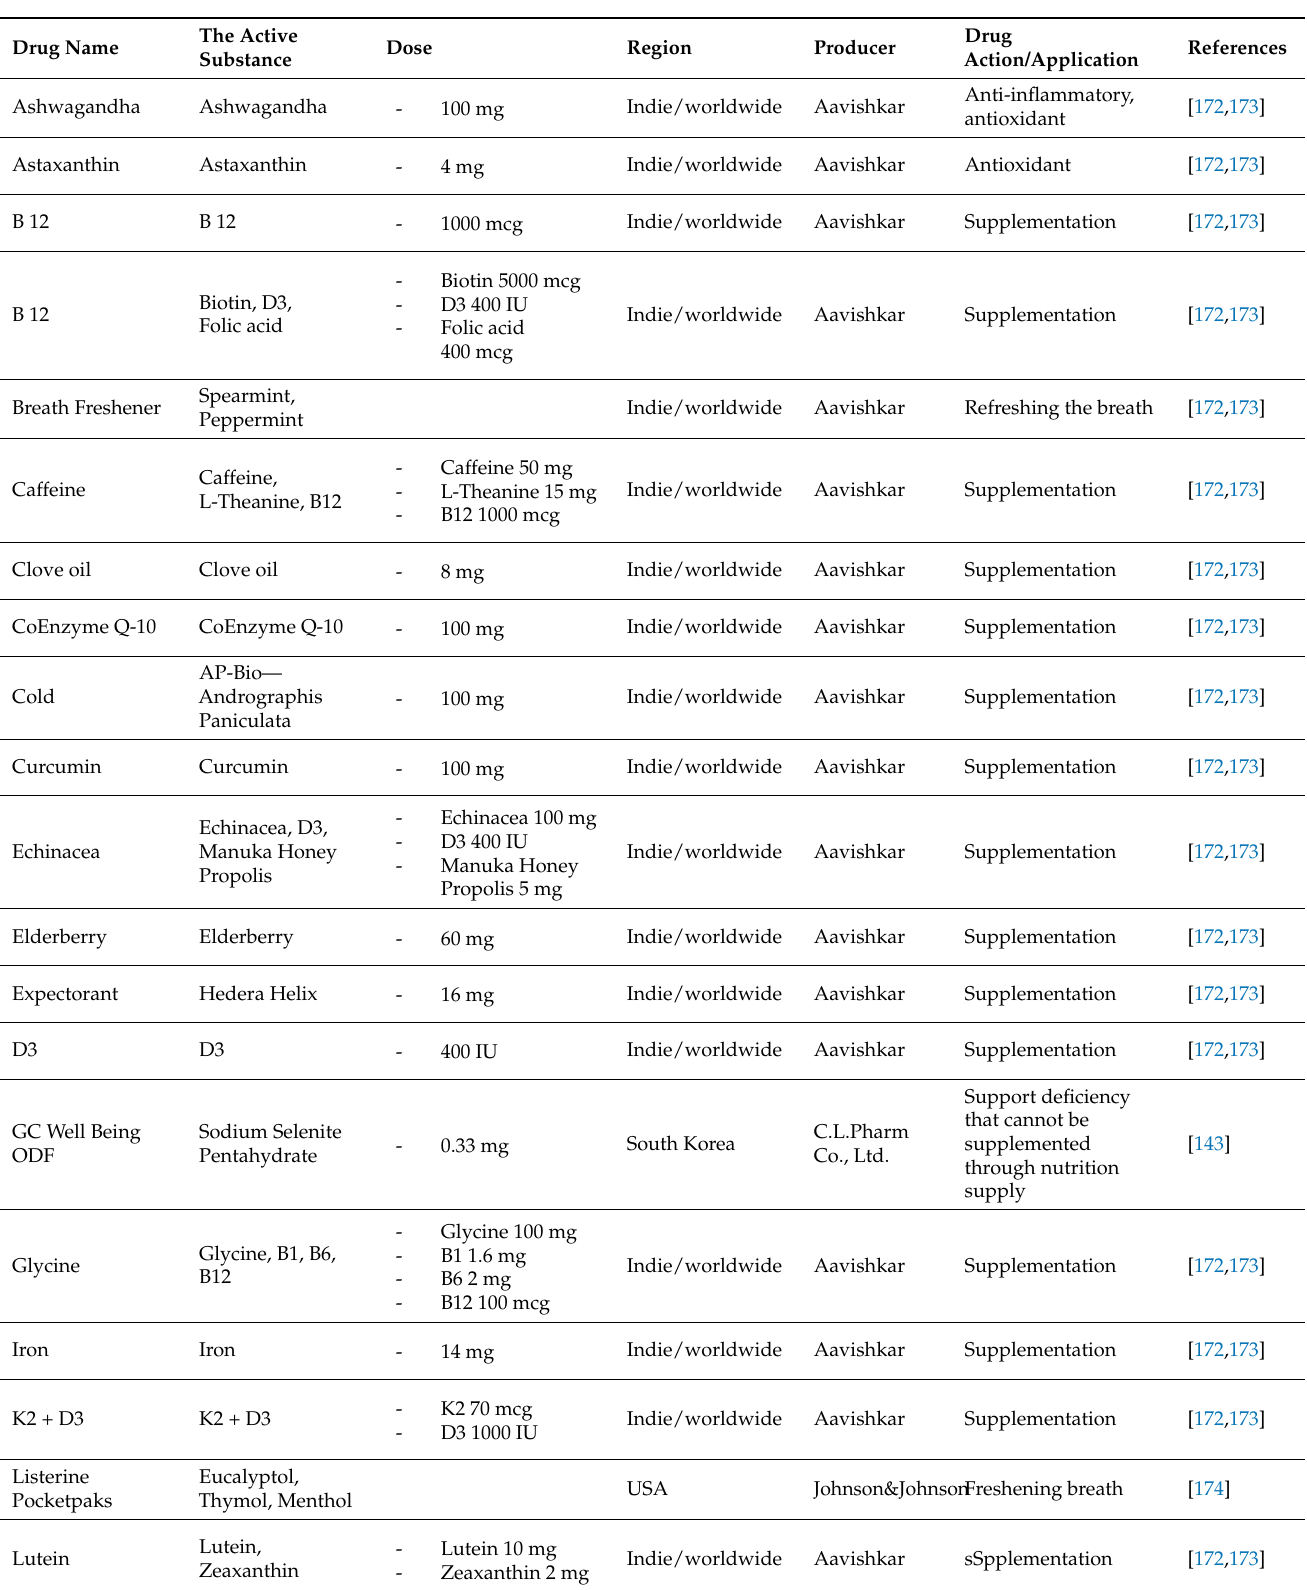
Table 4. Examples of ODF